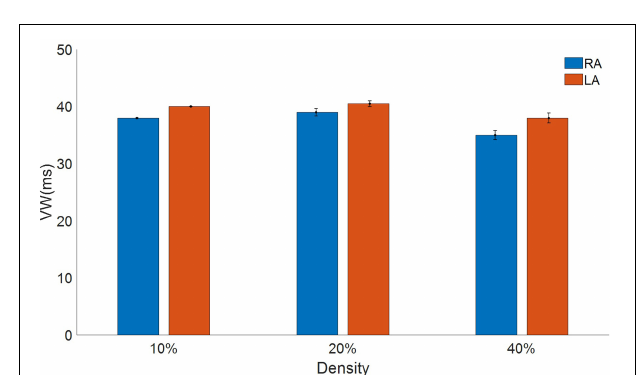
FIGURE 8 | Vulnerable window to reentry in atrial tissue with different densities of myofibroblasts indicated in percentage for the right atrial (RA) in blue and the left atrial (LA) in red subject to persistent atrial fibrillation